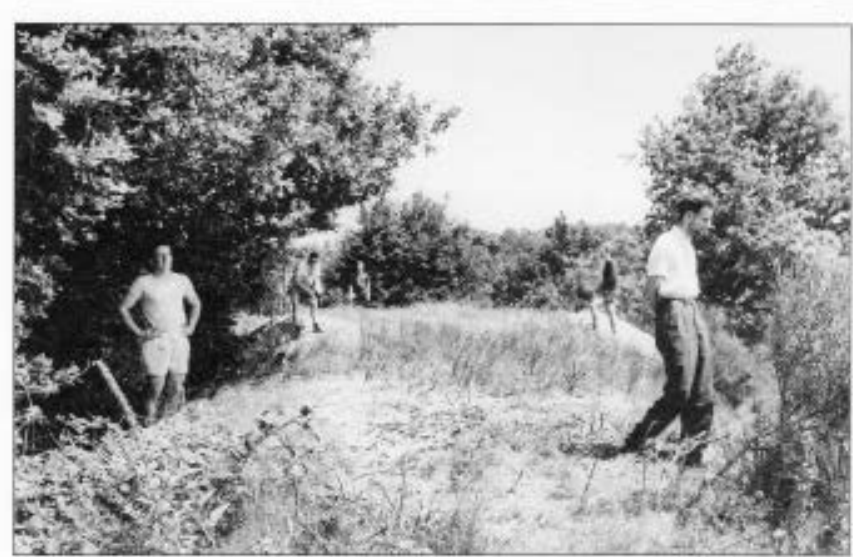
Figure 4 On the ramparts at the Camp du Chariot in 1959; left to right, Charles High am, William Manning, Richard Harper, Richard Higham and John Ellison. beginning of my second year